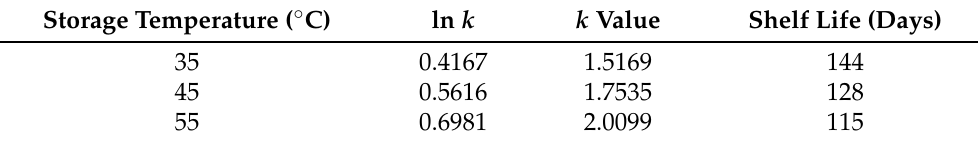
Table 3. The shelf life of dried coconut chips store at various temperatures with PV parameters.